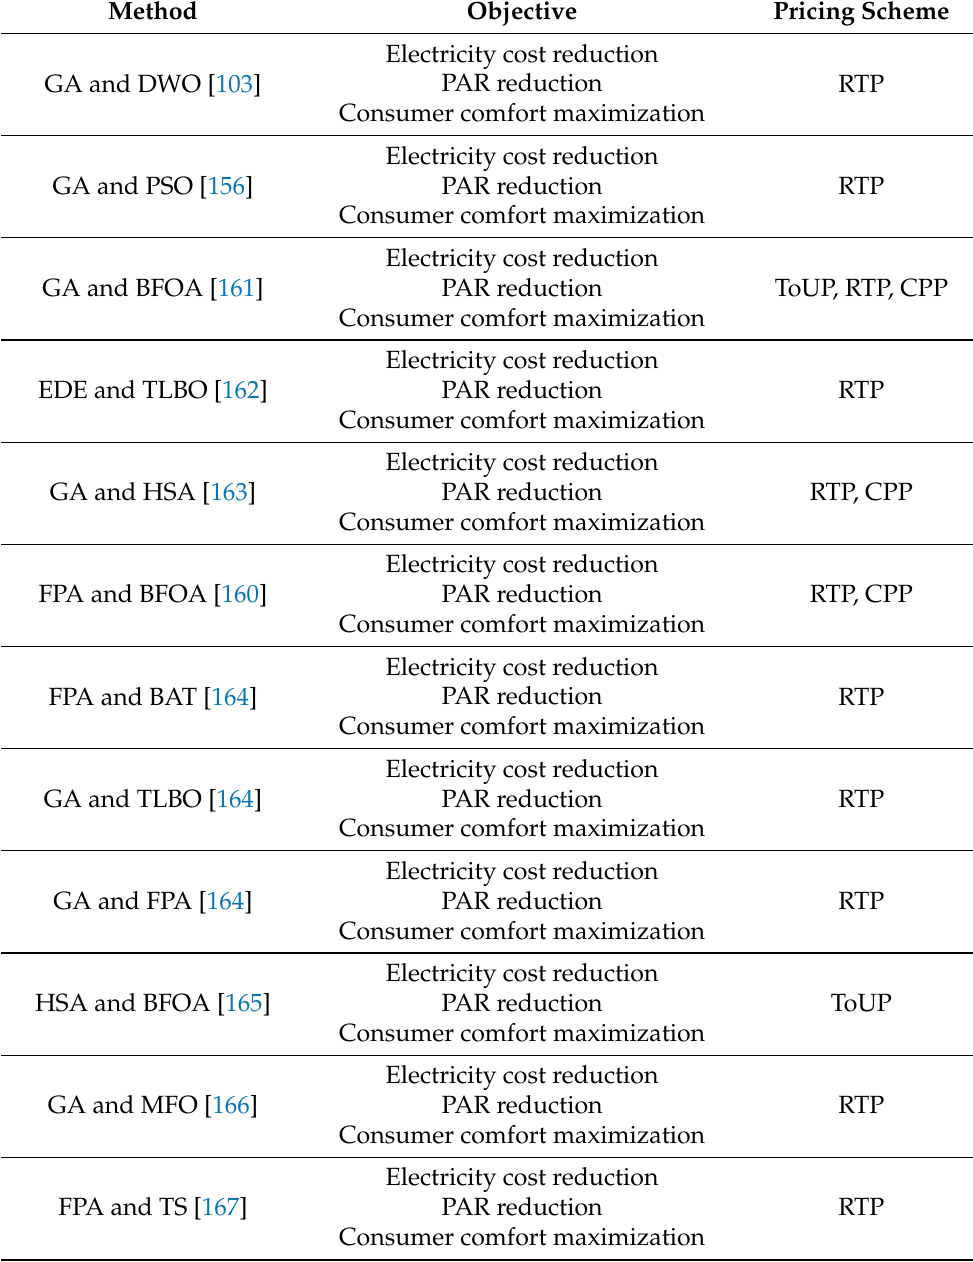
Table 8. Hybrid heuristic techniques. Extension of techniques reviewed in